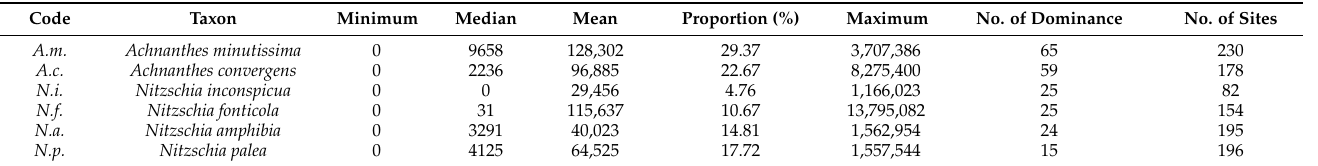
Table 2. Seven descriptive statistics for six diatom